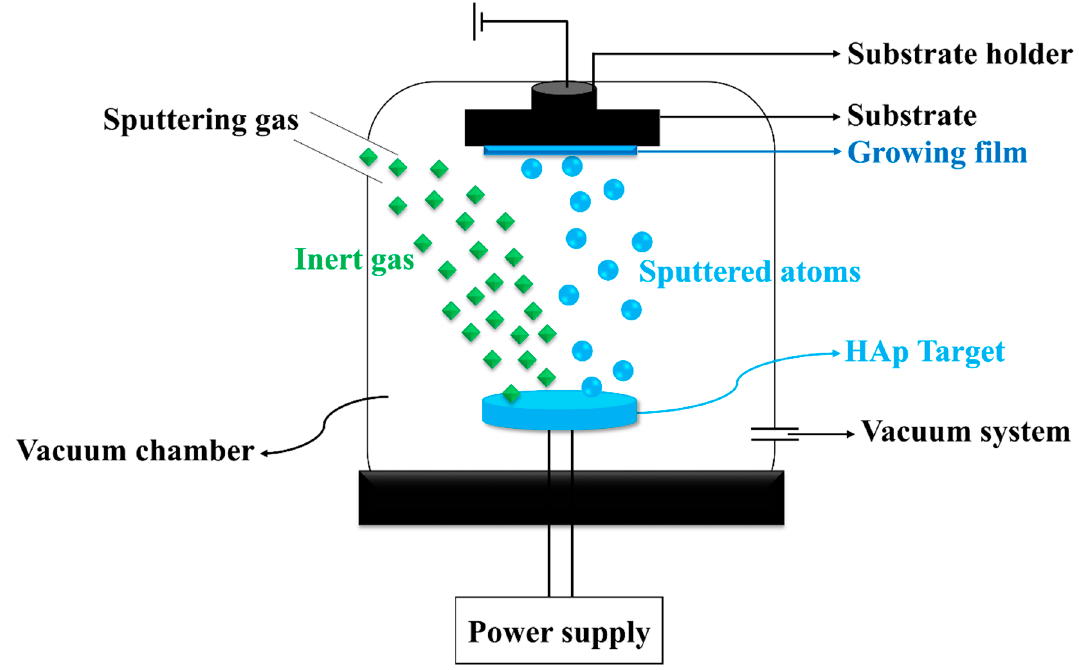
Figure 3. A schematic illustration of physical vapor deposition (PVD) process for deposition of HAp coatings.